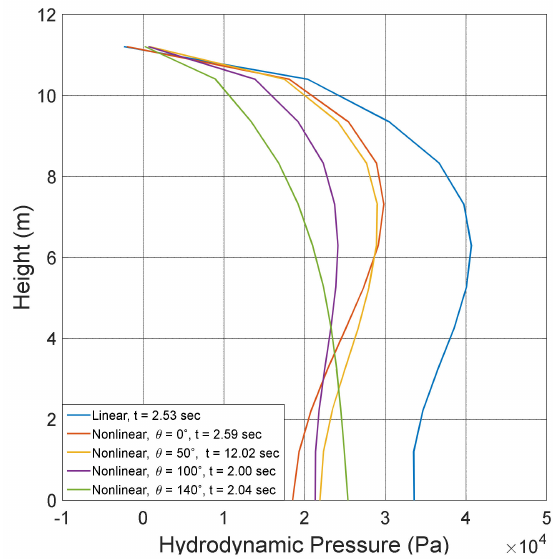
Figure 8. Hydrodynamic pressure distribution.